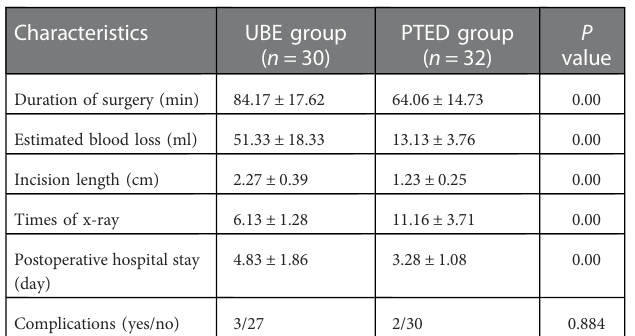
TABLE 2 Perioperative outcomes.